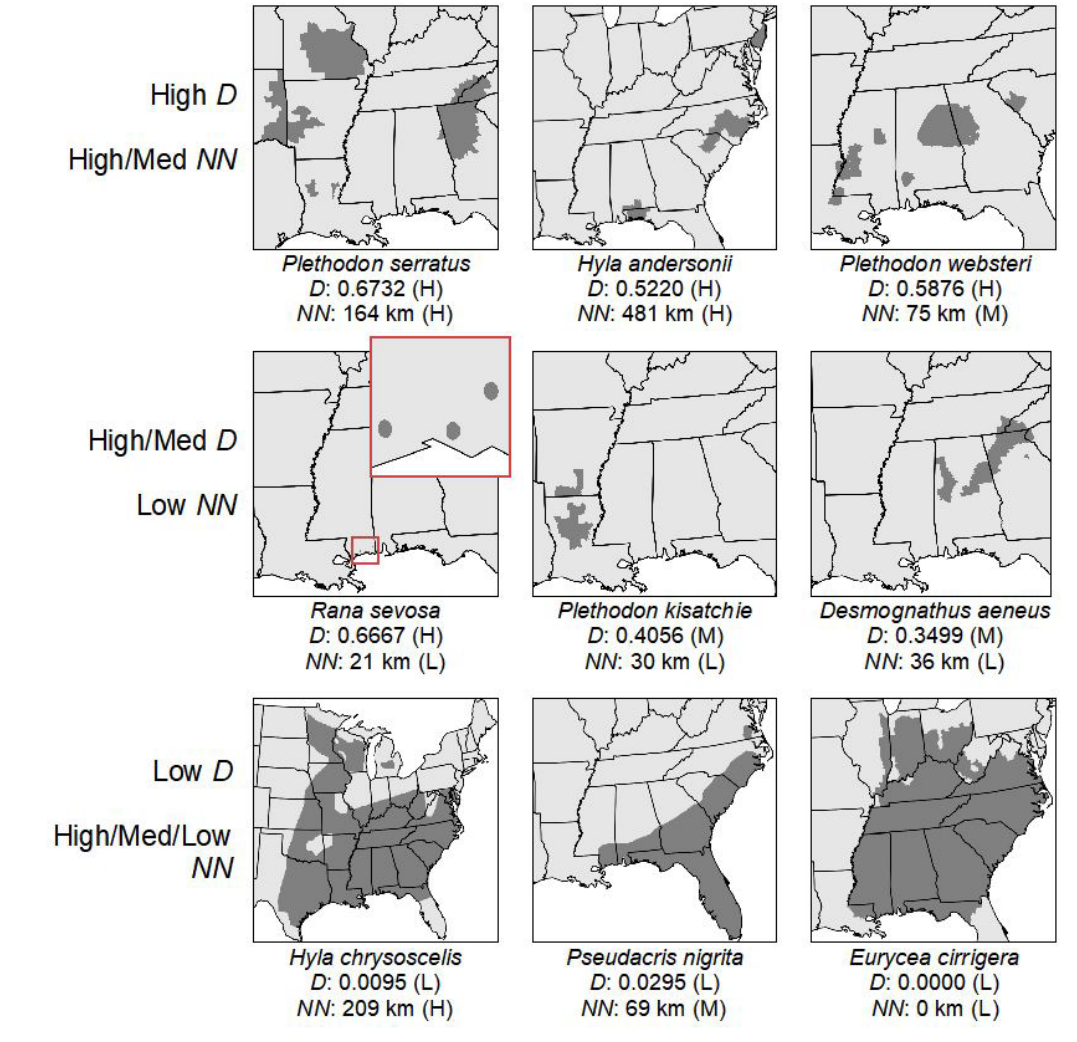
Figure 2. Examples of county-based ranges for various combinations of D and NN . H: high, M: moderate, L: